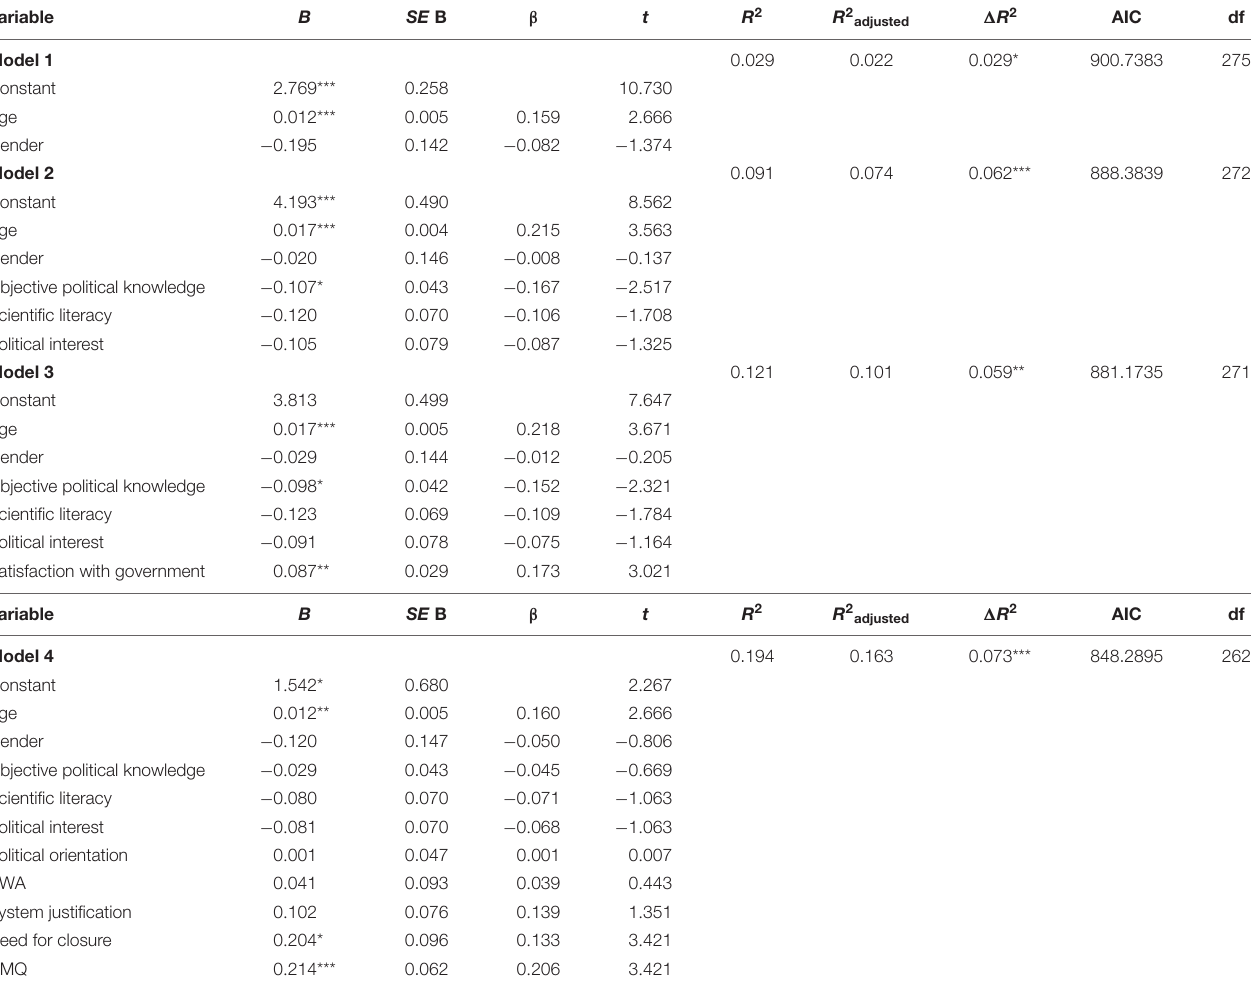
TABLE 6 | Hierarchical regression results for belief in non-political fake